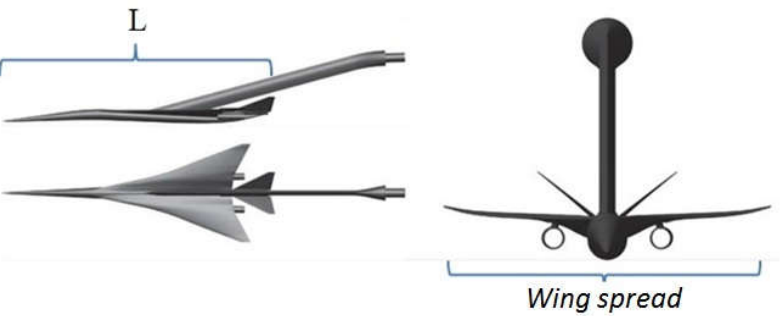
Figure 18. A model Figure 18. A model objects.